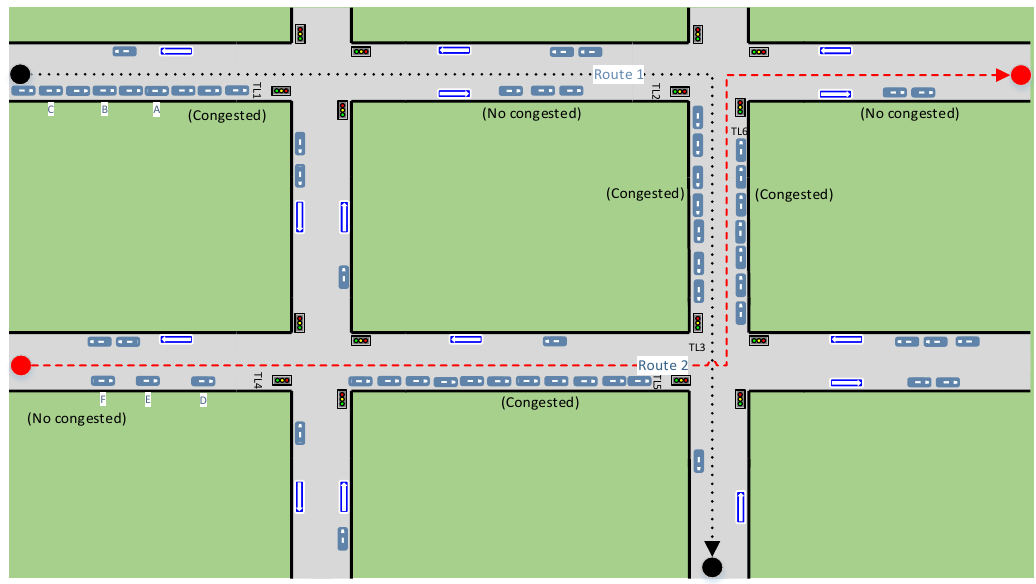
Figure 8. Traffic light duration time scenario.